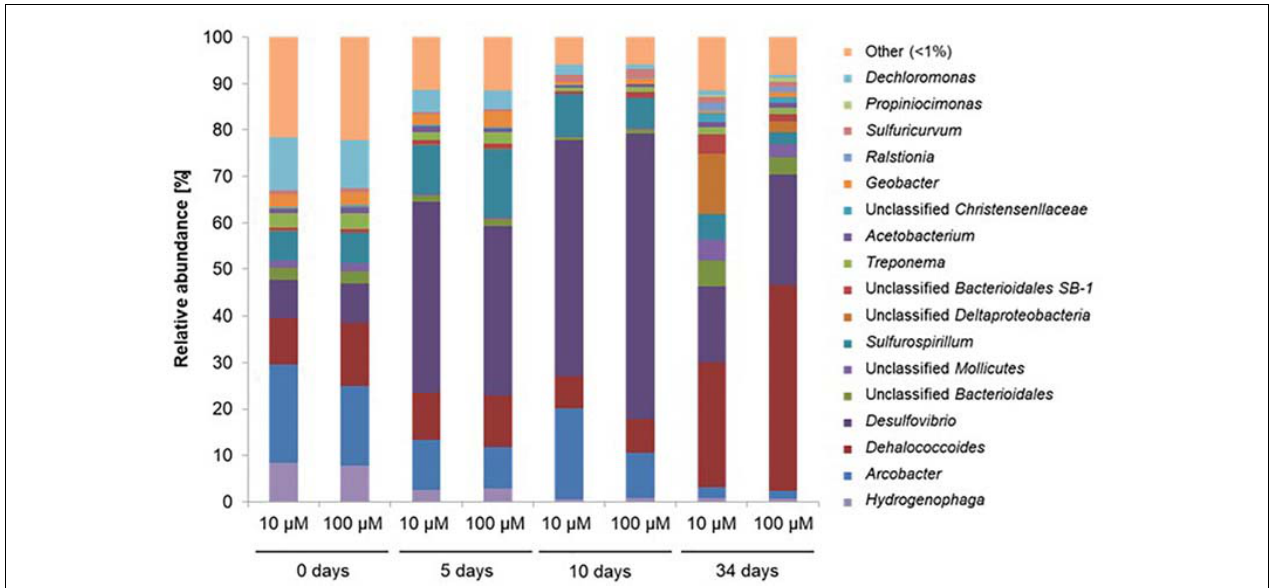
FIGURE 5 | Relative abundance of the 17 most abundant genus-level OTUs during CEs dissipation. Only data obtained for microcosms with acetate amendment were analyzed in detail. A total of 412,231 sequences of the V4–V5 region of the 16S rRNA gene were obtained by Illumina MiSeq and analyzed with Qiime software. 10 µ M, 100 µ M: concentrations of PCE added. OTUs with < 1% abundance were clustered together.